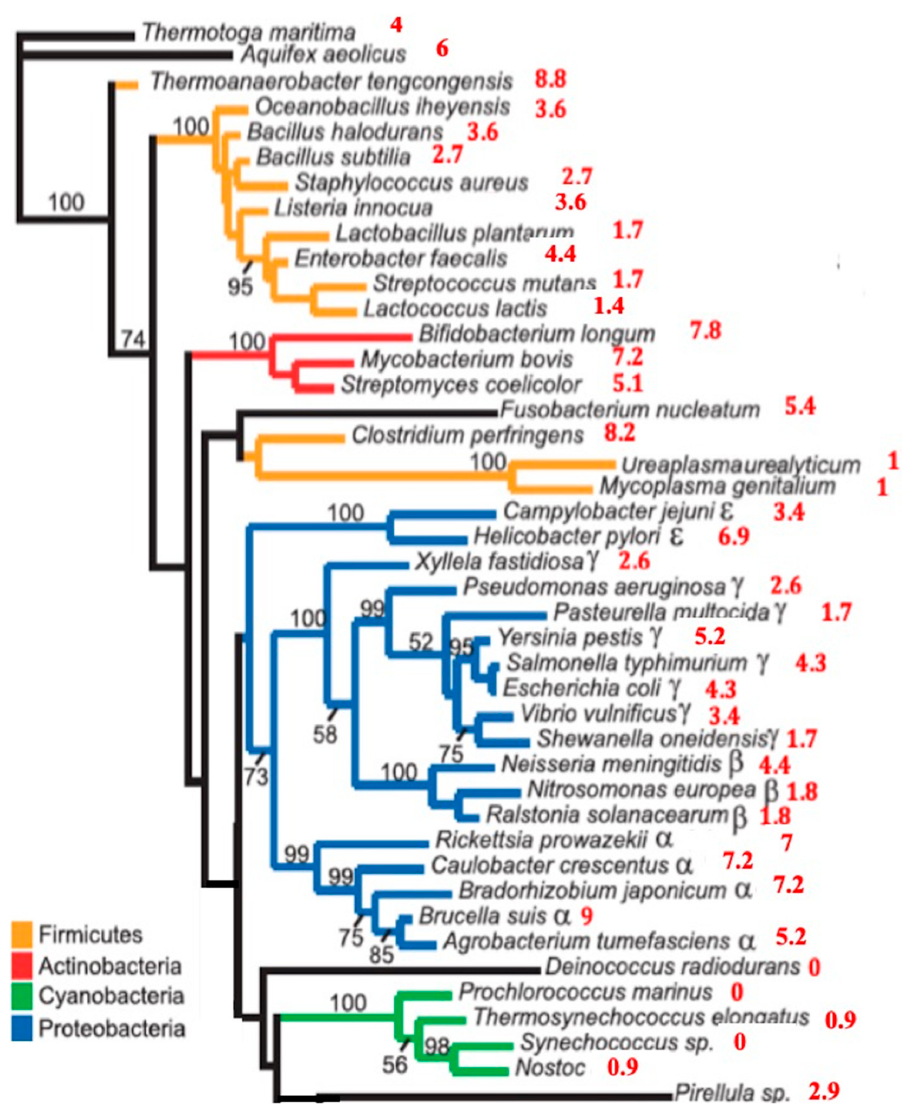
Figure 4. Bacteria phylogeny (from [60]) based on the sequences of the 16S ribosomal RNA genes. The numbers at the periphery of the phylogeny indicate the ALPHA pentamer-proximity P 22 of the 5S ribosomal RNAs (in red).